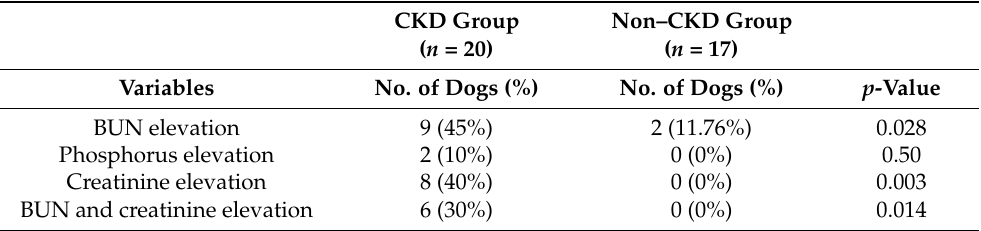
Table 5. Clinically relevant serum BUN, creatinine, and phosphorus increase in the CKD group/non– CKD group. CKD Group Non–CKD Group ( n = 20) ( n = 17) Variables No. of Dogs